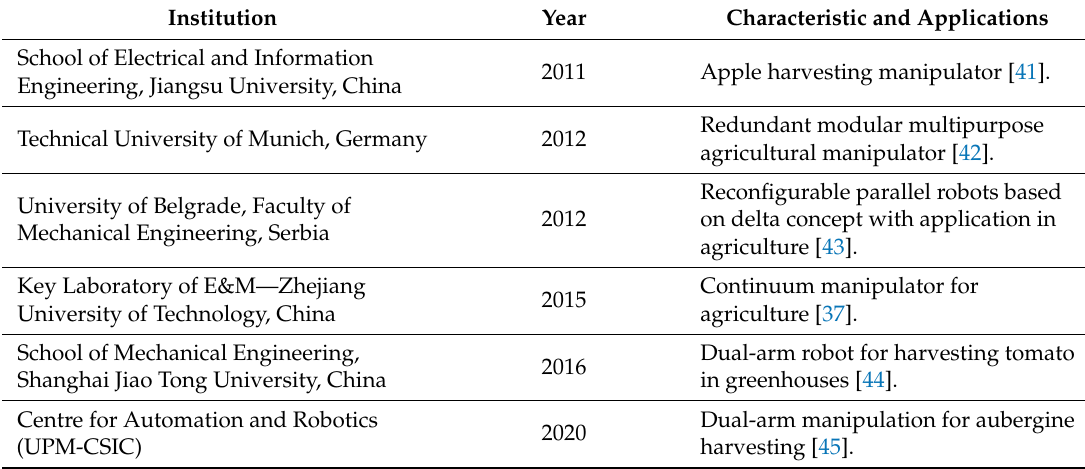
Table 1. Examples of di ff erent types of manipulators for